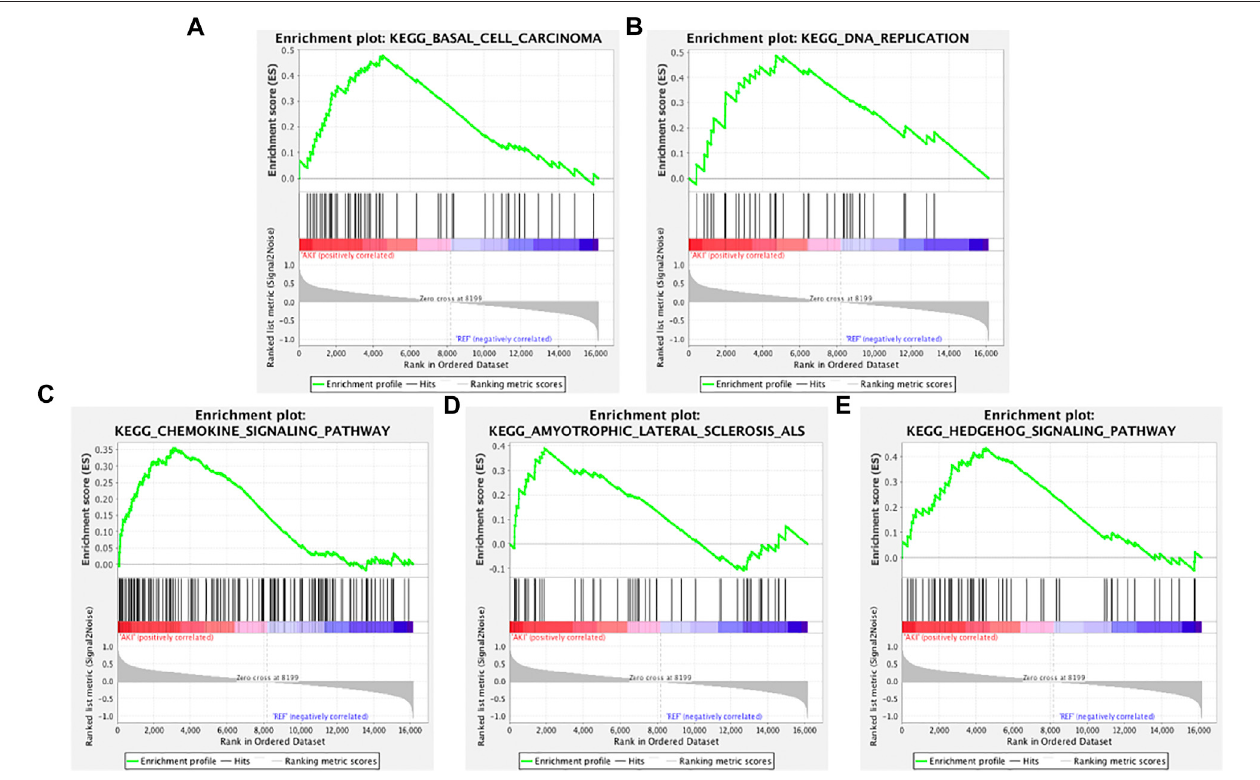
FIGURE2| EnrichmentplotsfromGSEAofupregulated pathwaysinAKI.GSEAresultsshowingtheupregulated pathwaysof (A) “ basalcellcarcinoma, ” (B) “ DNA replication, ” (C) “ chemokine signaling pathway, ” (D) “ amyotrophic lateral sclerosis, ” and (E) “ Hedgehog signaling pathway. ”